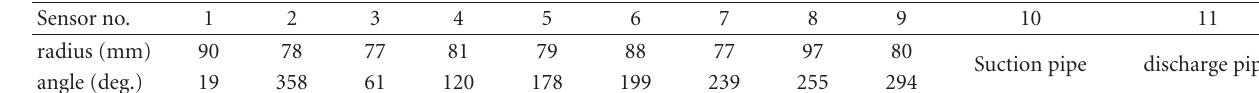
Table 1: Coordinates of measuring locations.